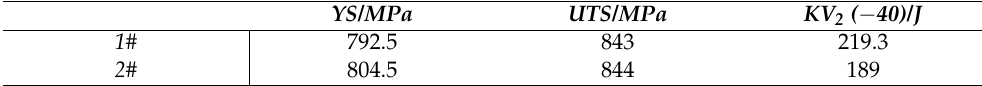
Figure 1. ( a ) Microstructure of model steel 1#, ( b ) microstructure of model steel 2#. Table 2. Mechanical properties of model